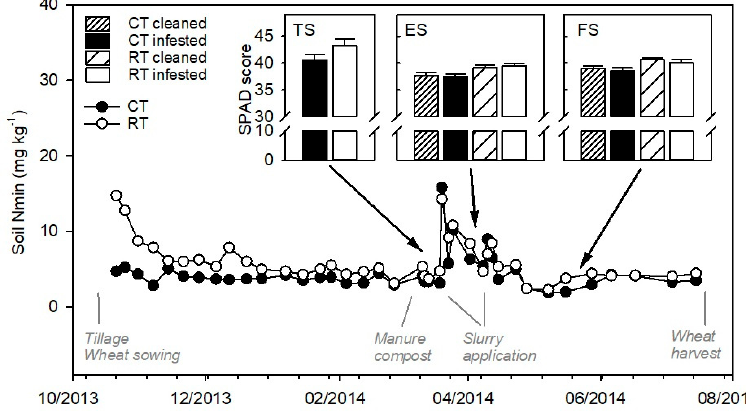
Figure 3. Soil mineral nitrogen concentrations in 0–20 cm (Nmin, mg kg − 1 ) during the wheat growing season 2013 / 2014 (selection modified after Figure 1 in Reference [26]). Major field management is shown below. Bar plots show SPAD scores at major wheat stages (TS = Tillering, ES = Stem elongation, FS = Flowering). CT = ploughing, RT = reduced tillage.